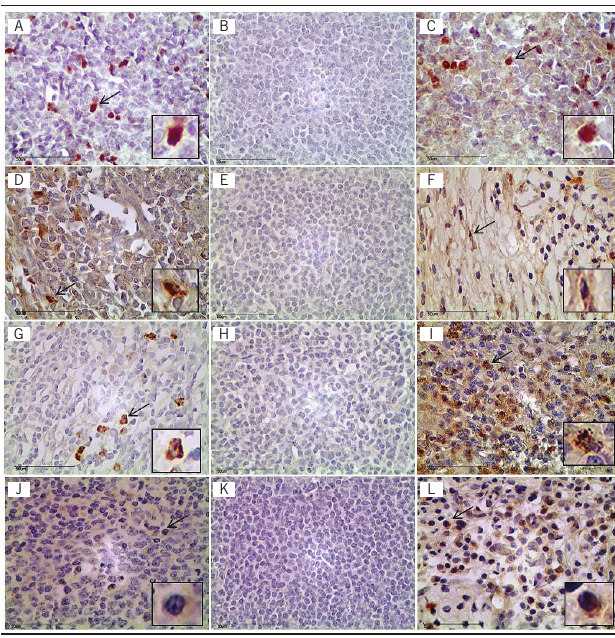
figurE − Immunohistochemical double staining of CD25/FOXP3 and simple staining of TGF- β , IL-10 and IFN- γ A) positive control human tonsil stained with anti-human CD25 and anti-human FOXP3 antibodies; B) negative control human tonsil with omission of the primary antibodies, showed no staining; C) HSIL, with CD25 + FOXP3 + cells in large quantities; D) positive control human tonsil stained with anti-human TGF- β antibodies; E) negative control human tonsil with omission of the primary antibodies, showed no staining; F) HSIL, with TGF- β + cells in large quantities; G) positive control human tonsil stained with anti- human IL-10 antibodies; H) negative control human tonsil with omission of the primary antibodies, showed no staining; I) HSIL, with IL-10 + cells in large quantities; J) positive control human tonsil stained with anti-human IFN- γ antibodies; K) negative control human tonsil with omission of the primary antibodies, showed no staining; L) HSIL, with IFN- γ + cells in large quantities. All figures are presented in the same magnification (400×) CD25: interleukin-2 receptor alpha; FOXP3: forkhead box P3; TGF- β : transforming growth factor beta; IL-10: interleukin-10; IFN- γ : interferon-gamma; HSIL: high-grade